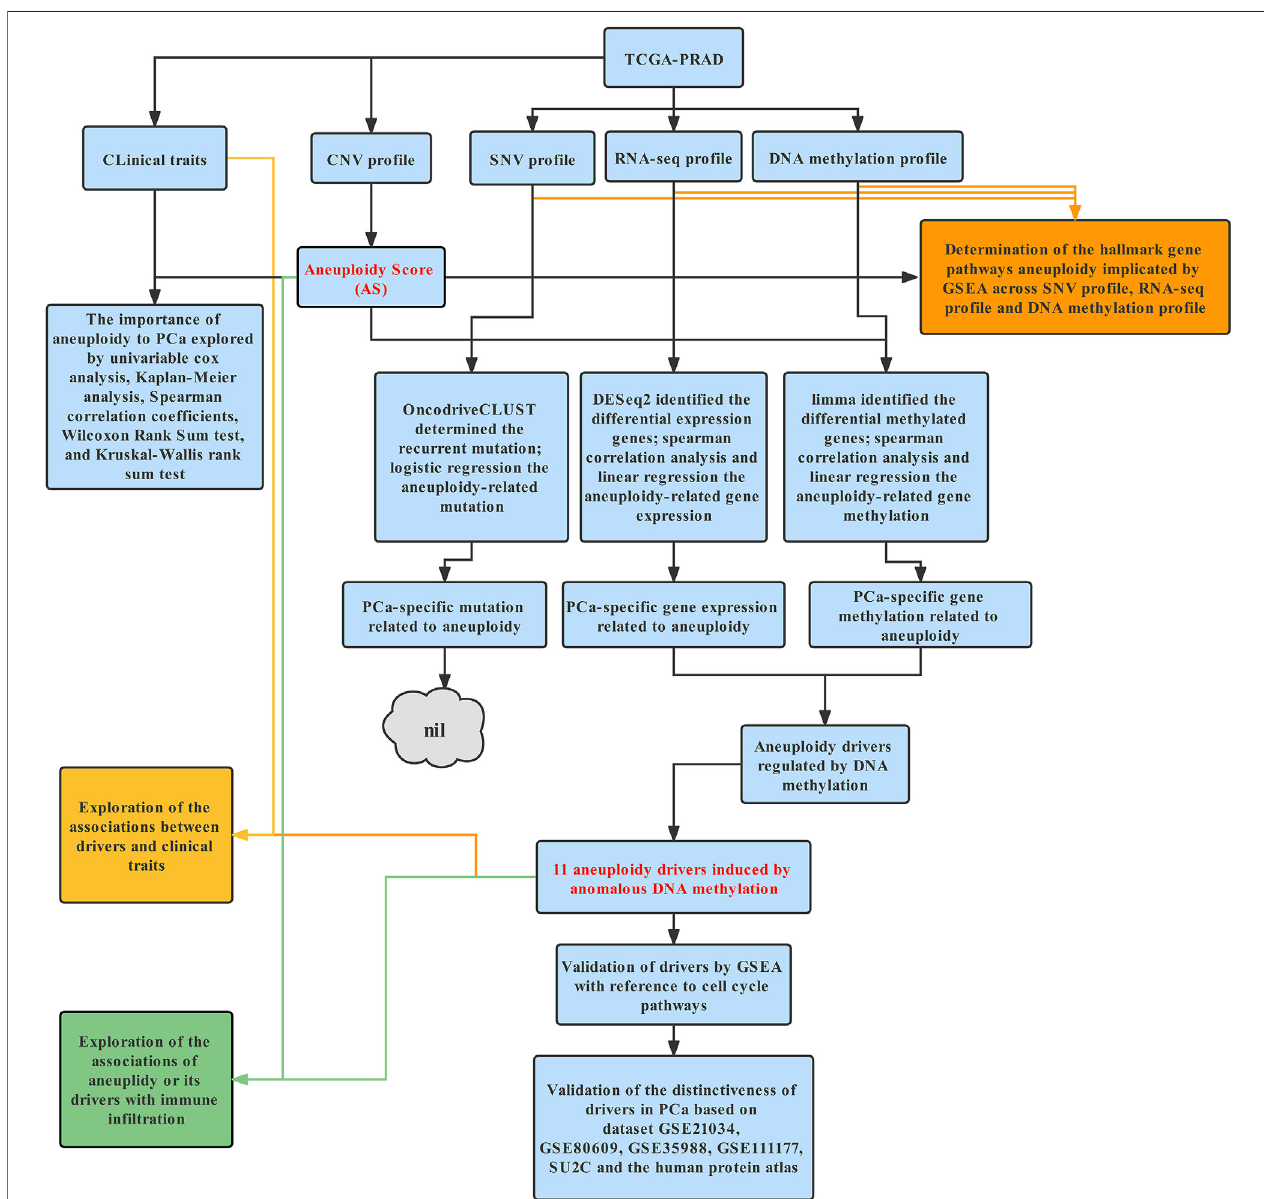
FIGURE 1 | Schematic diagram of this study. Brie fl y, data including CNV data, SNV data, methylation beta values, and RNA-sequencing data of PCa were downloadedfromTCGA.ABSOLUTEwasusedtoestimateAS.GSEAwasappliedtoillustratemolecularprocessofaneuploidyinmutation,methylation,andexpression pro fi le. Next, we tried to identify aneuploidy drivers; as abnormal expression levels of aneuploidy driver genes may stem from alternative genetic or epigenetic mechanisms and genes mainly exert their in fl uence by gene expression, we could identify potential aneuploidy driver genes by intersecting aneuploidy-related mutationpro fi leorgenemethylationpro fi lewithPCa-speci fi cgeneexpression.Finally,Consideringthecloseassociationbetweenaneuploidyandcellcyclepathway,we applied GSEA to validate underlying connection of aneuploidy with driver genes. Further exploration and validation of driver genes were conducted in cBioPortal, GEO, and Human Protein Atlas database.